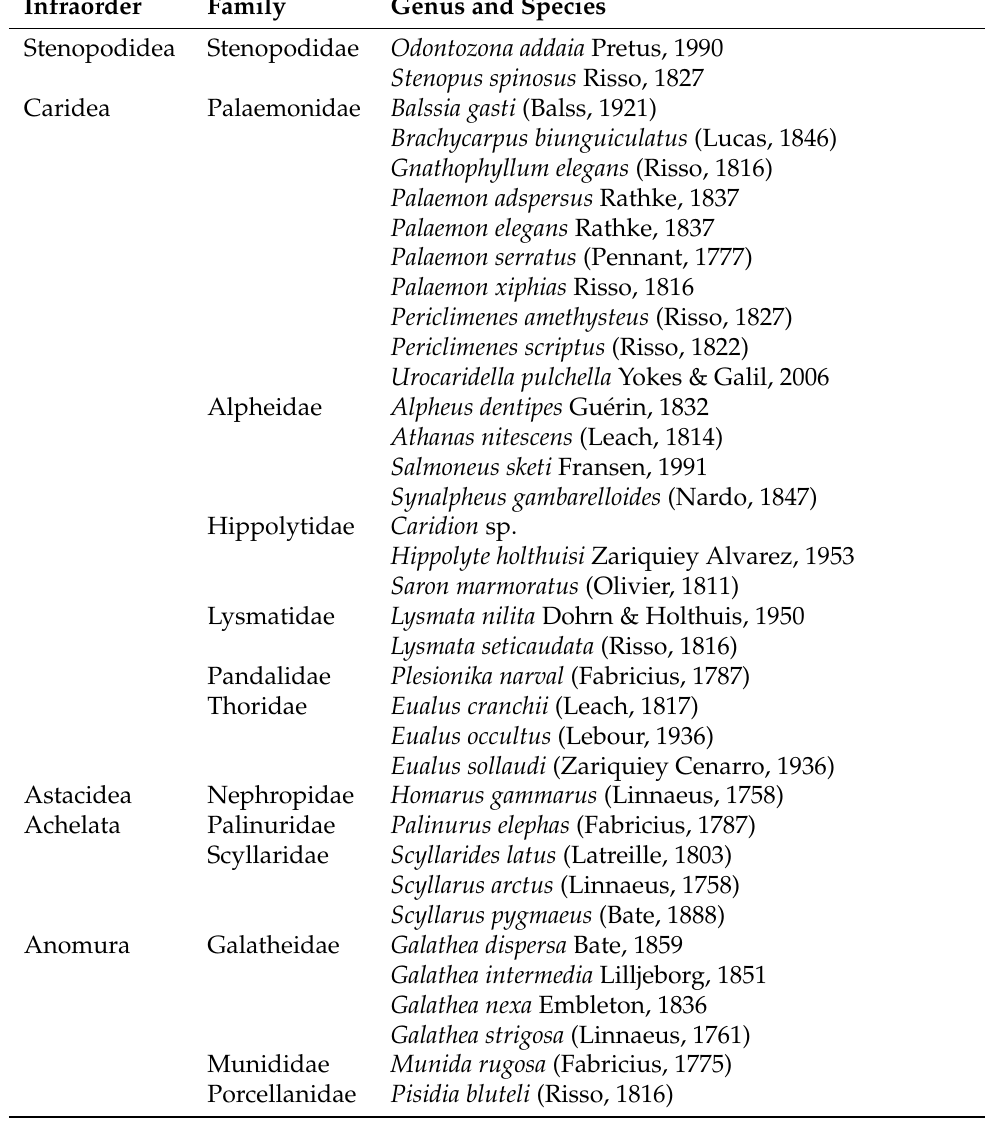
Table 1. List of the species of decapod crustaceans found in marine caves of the Mediterranean Sea.